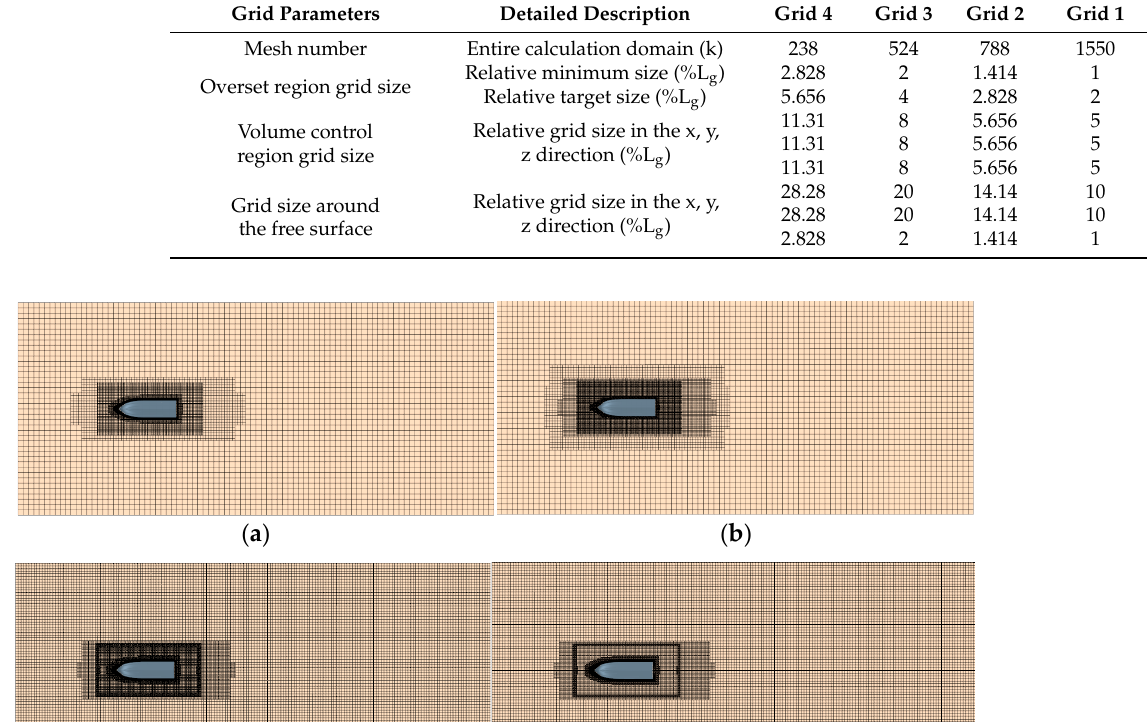
Table 4. Resistance comparisons of the test (EFD) and numerical (CFD) results for different